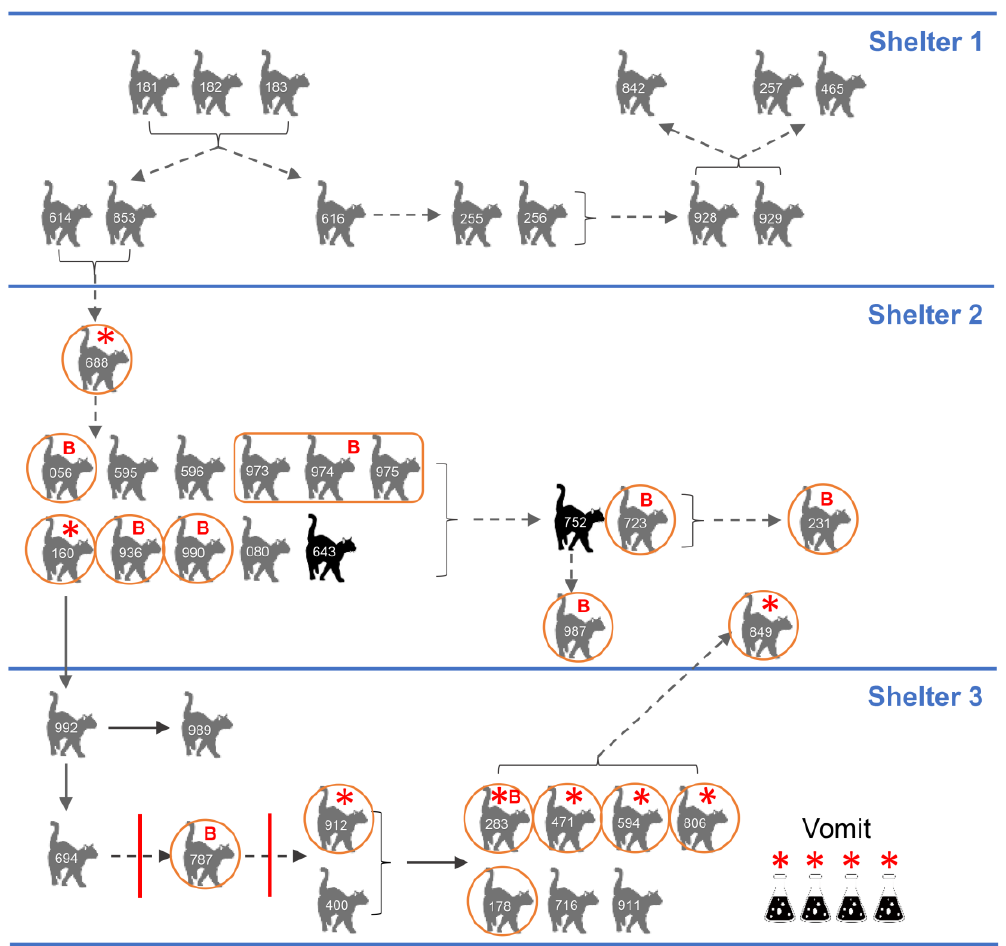
Figure 2. Outbreak diagram in three shelters. Animal ID shown for each cat (also see Supplementary Tables). Grey cats: clinically affected and recovered; black cats were euthanized. Red circle around a cat means feces was sampled individually; rectangle around the three cats means a litter of kittens were sampled together. Solid arrow means direct or indirect contact possible (housed communally), dotted line means indirect contact only. Bracket indicates group of affected animals with transmission to another group. Red solid vertical line indicates failed clean break. Red star indicates fechavirus PCR positive cats/samples. Red letter “B” means FeBoV PCR positive cats/samples.